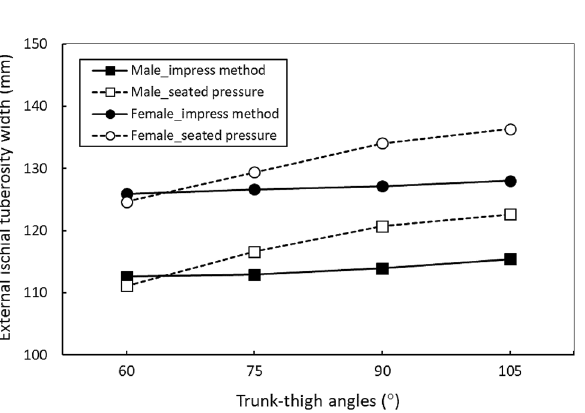
Figure 4. Comparisons of external ischial tuberosity width values under different testing conditions.